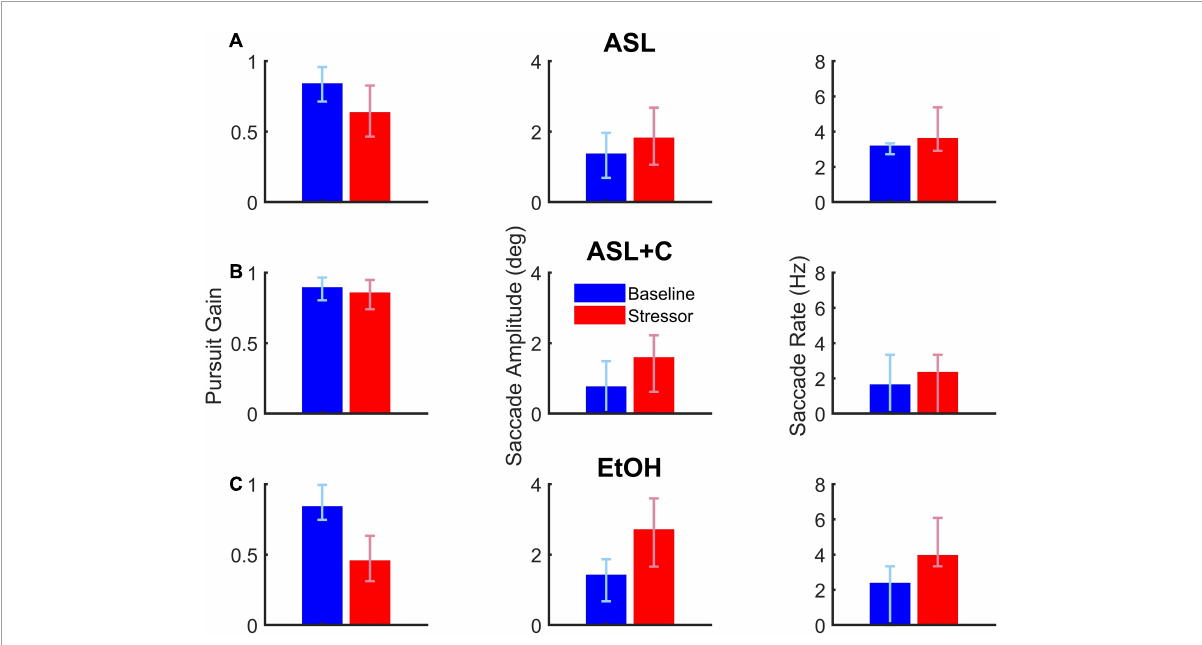
FIGURE3 The effects of acute sleep loss without ( A , ASL, 24.5 h awake) and with a caffeine countermeasure ( B , ASL+C, 22.6 h awake) and of low-dose alcohol ( C , EtOH, 0.033% BAC) for a single example participant. Each row shows summary data of the three raw oculometrics (i.e., pursuit gain, saccadic amplitude, and saccadic rate) used to derive the saccadic compensation metrics (i.e., ground lost and group recouped) for each of the above three conditions. The columns from left to right show bar charts of pursuit gain and saccadic amplitude with the red and blue vertical bars indicating the median of the stressor and baseline distributions of a 90–180 trial run, respectively, and the error bars indicating the interquartile range. For saccade rate, the vertical bars show the total number of saccades divided by the total duration of the steady-state period (i.e., 300 ms per trial) across all 90–180 trials, with the error bars indicating the interquartile range for the trial-by-trial saccade rate across trials. Pursuit gain is impaired in both the ASL and EtOH conditions. Saccadic rate and amplitude, however, show larger increases in the EtOH condition, suggesting more effective compensatory neural mechanisms under low-dose alcohol as compared with a night of sleep loss. Caffeine appears to remedy most of the pursuit deficit, but saccadic behavior nonetheless appears abnormally elevated with respect to